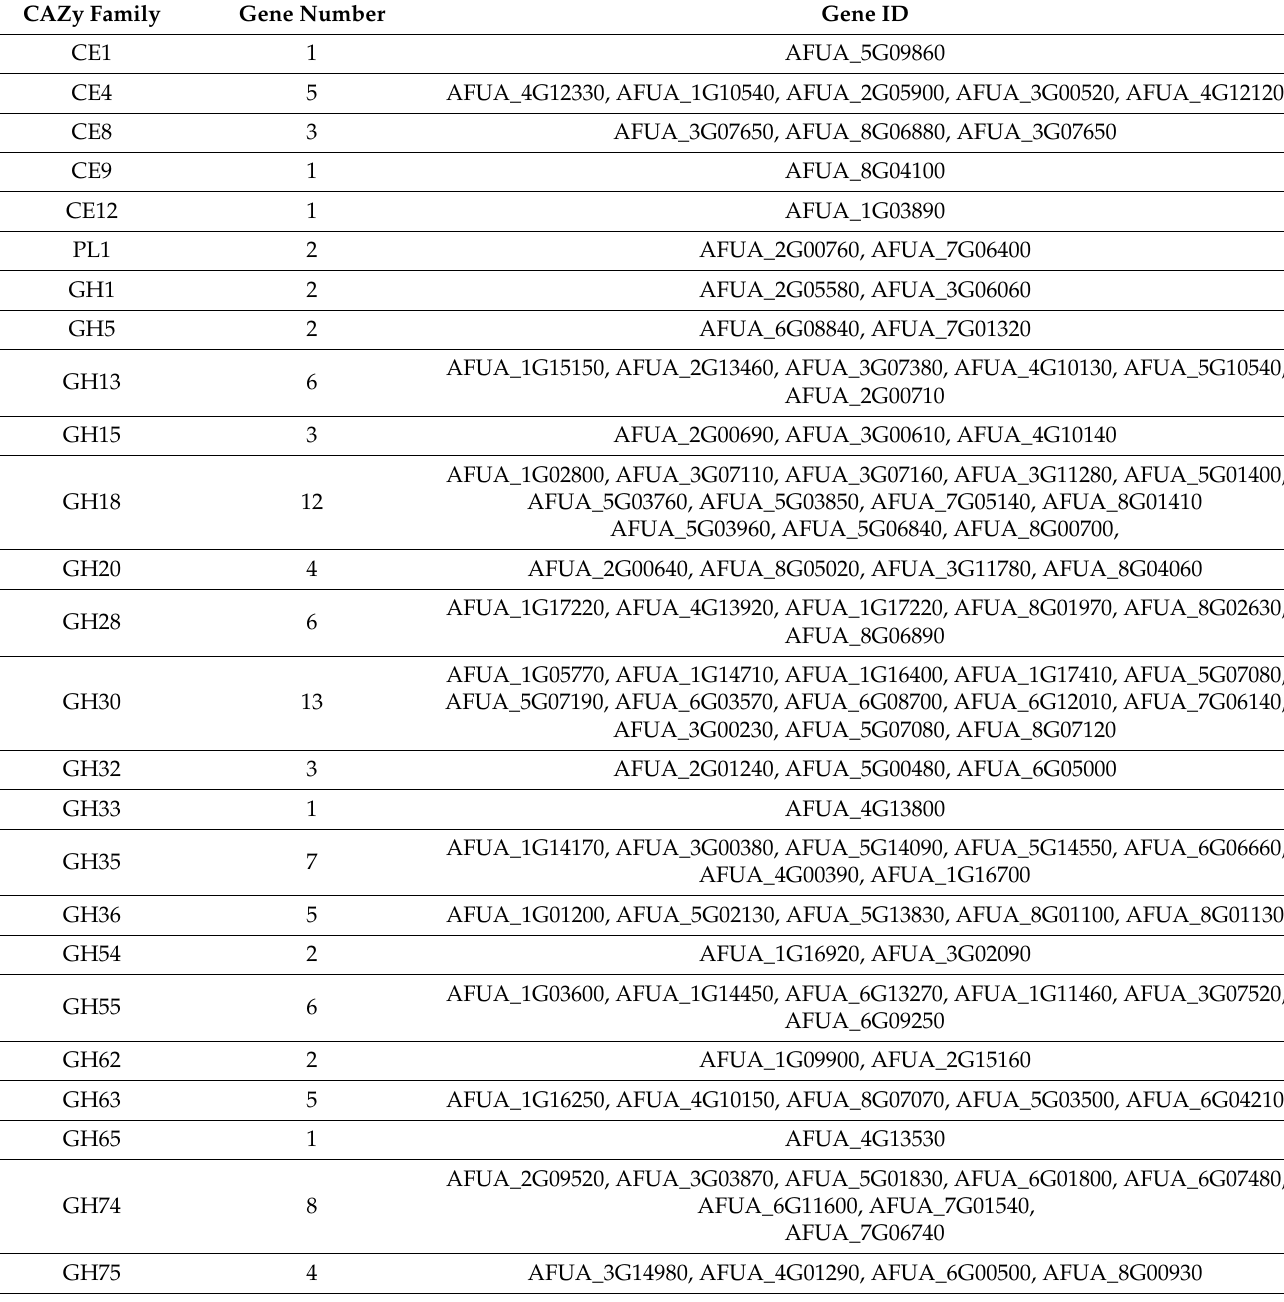
Table 1. CAZy-encoding genes identified from the transcriptome of A. fumigatus